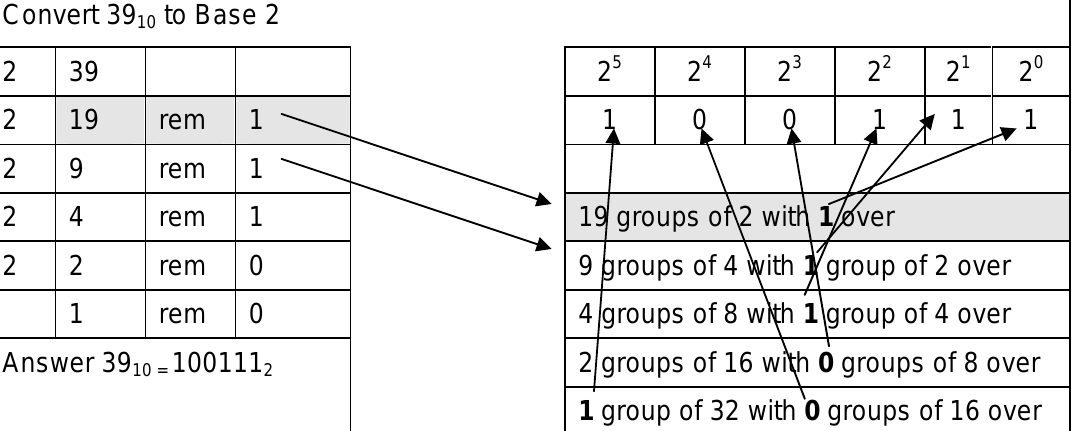
Figure 6. Converting Base 10 to Base